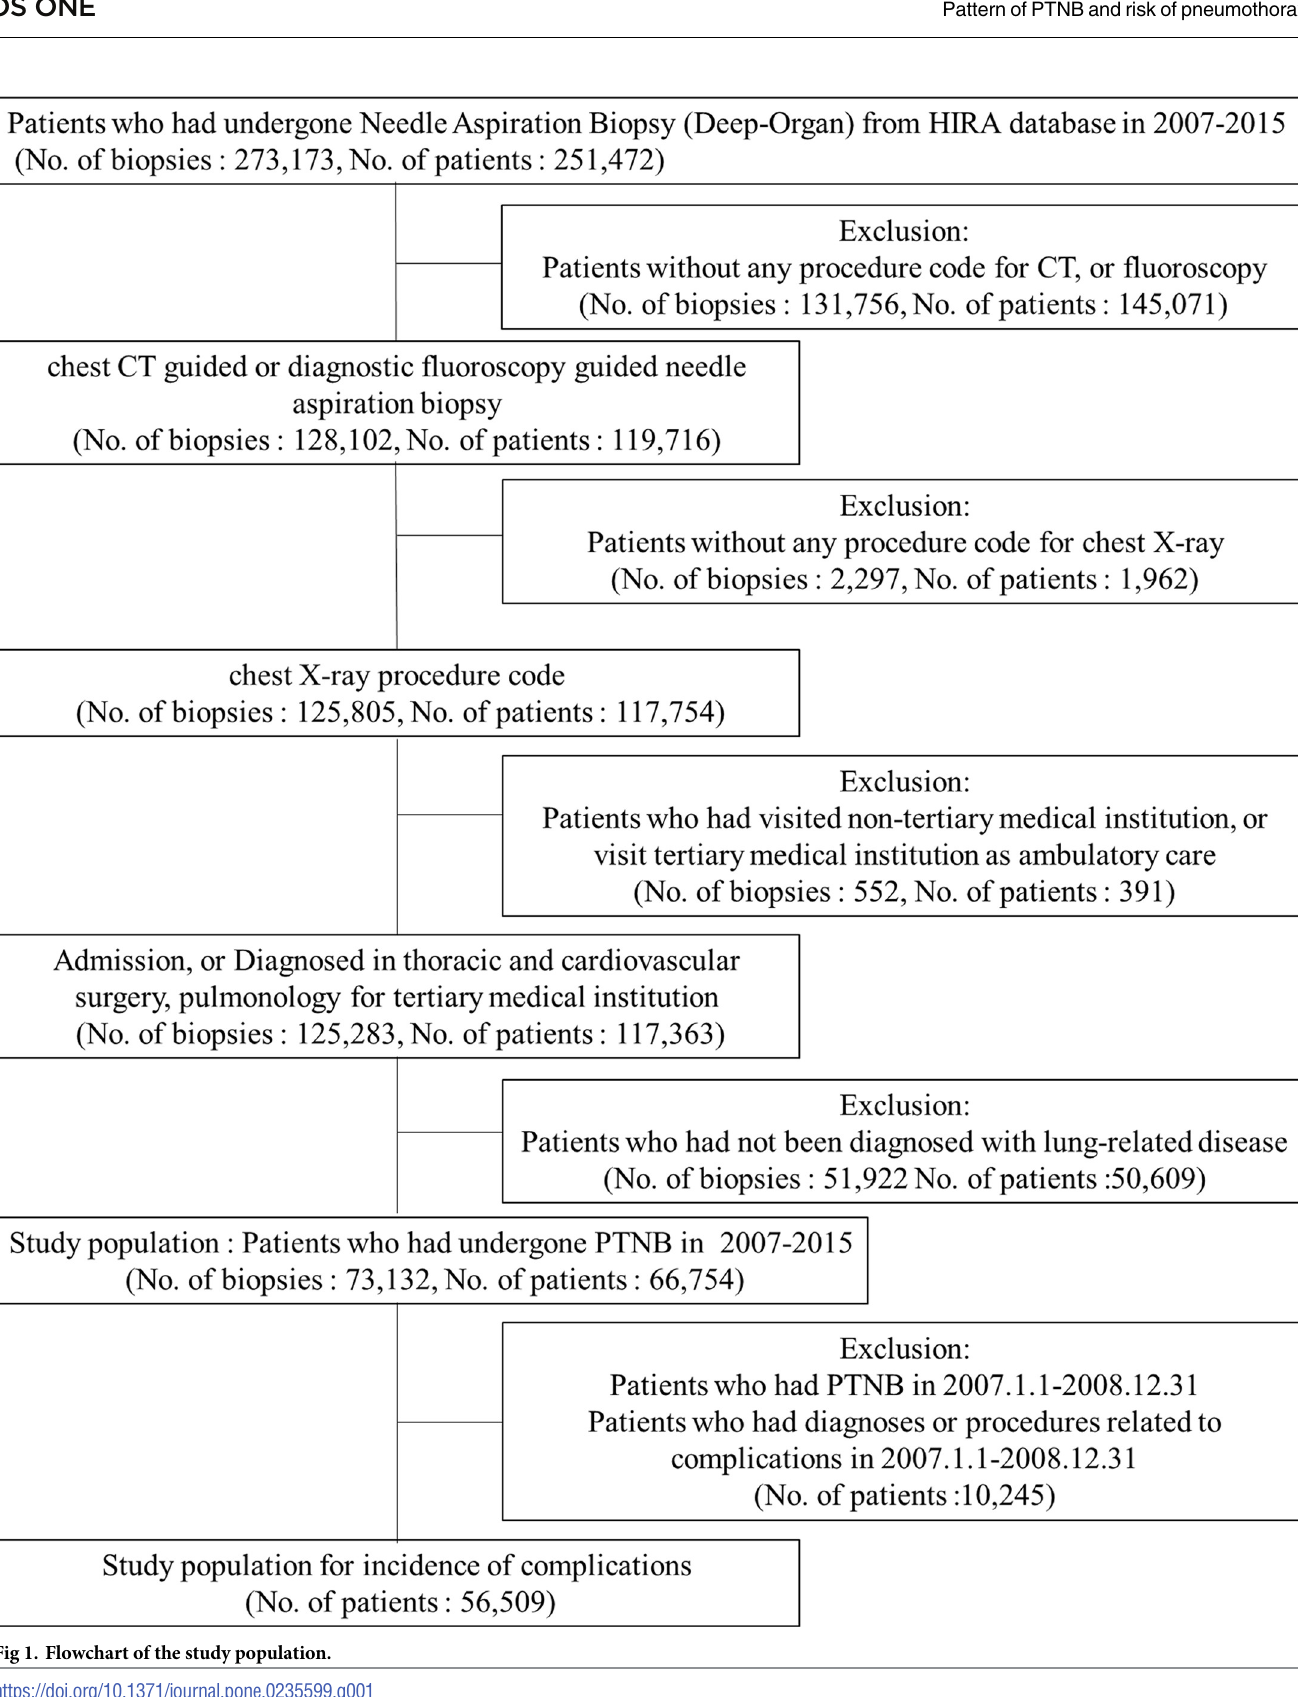
PLOS ONE | https://doi.org/10.1371/journal.pone.0235599 July 10,